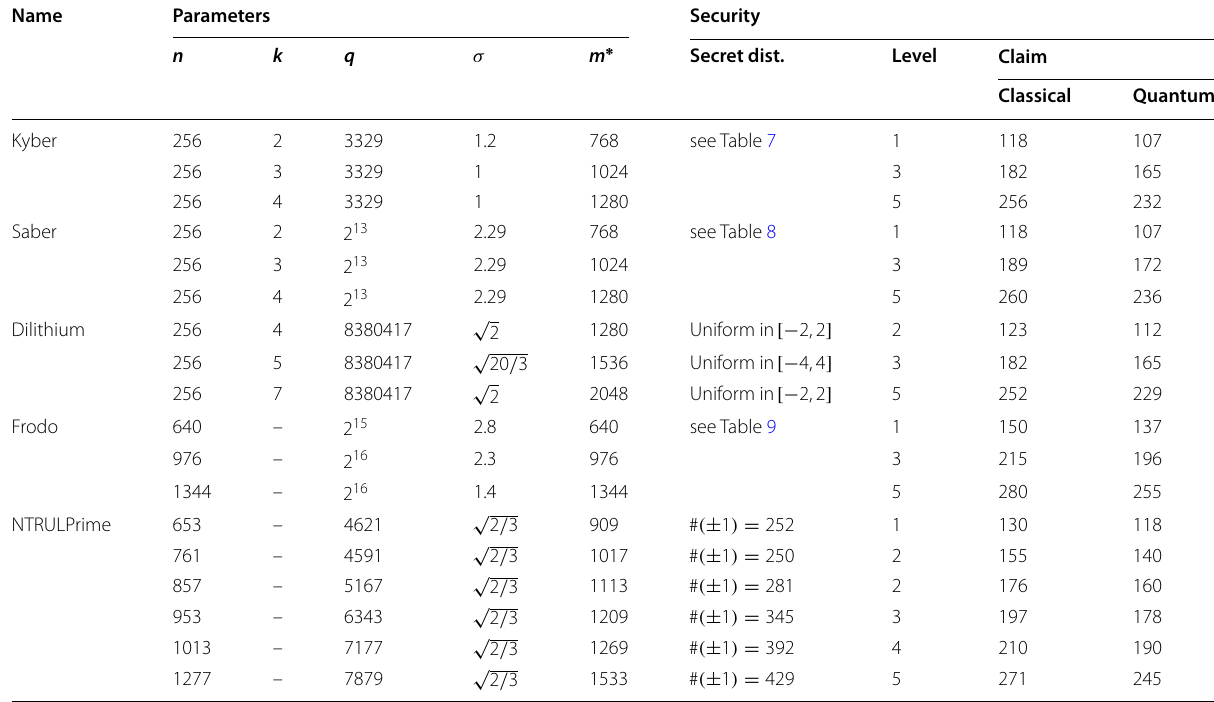
Table 6 Parameters for NIST-PQC round 3 LWE-based